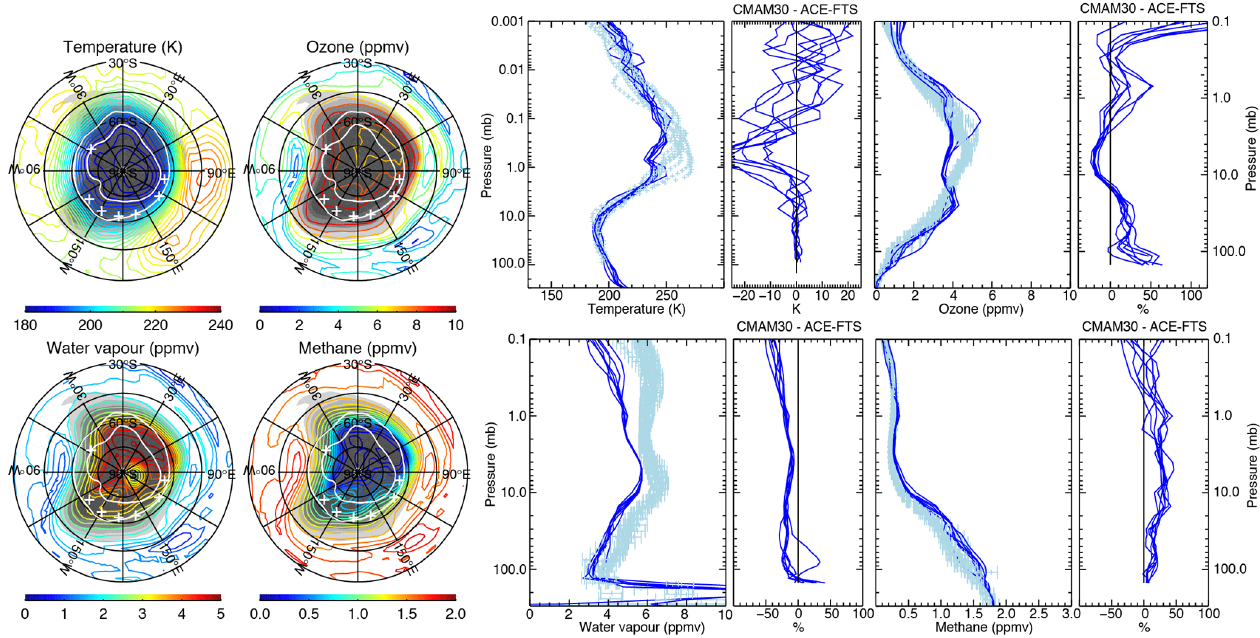
Figure 11. Left panels show the CMAM30 temperature, ozone, water vapour and methane on the 500K isentropic surface for 30 July 2006. Coloured contours are the constituent and/or temperature values. Scaled potential vorticity is shaded in grey (no shading less than − 1 × 10 − 4 s − 1 ; light shading at − 1 and − 1 . 2 × 10 − 4 s − 1 ; darker shading − 1.6 and − 1 . 8 × 10 − 4 s − 1 ). The white contours indicate where the temperature is below 196 and 188K. Right panels show coincident profiles for CMAM30 (dark blue) and ACE-FTS measurements (light blue) for temperature, ozone, water vapour and methane. Differences between CMAM30 and ACE-FTS are shown to the right of each panel. Locations of each profile are marked on the isentropic plots for ACE-FTS profiles (white crosses). Note there are no OSIRIS data available for this